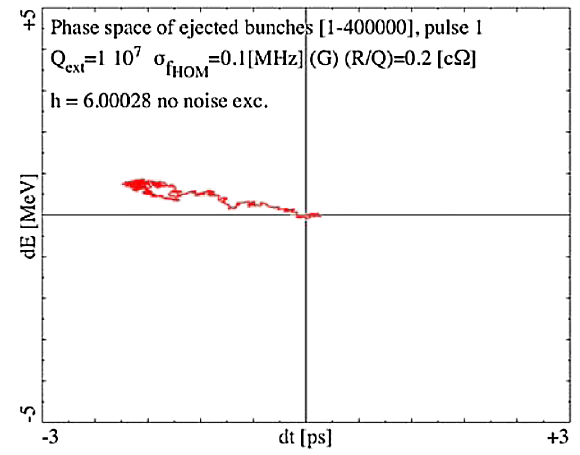
FIG. 47. (Color) Phase-space image of the ejected bunches of the second pulse. Conditions as Fig. 46 but Q ext ¼ 10 7